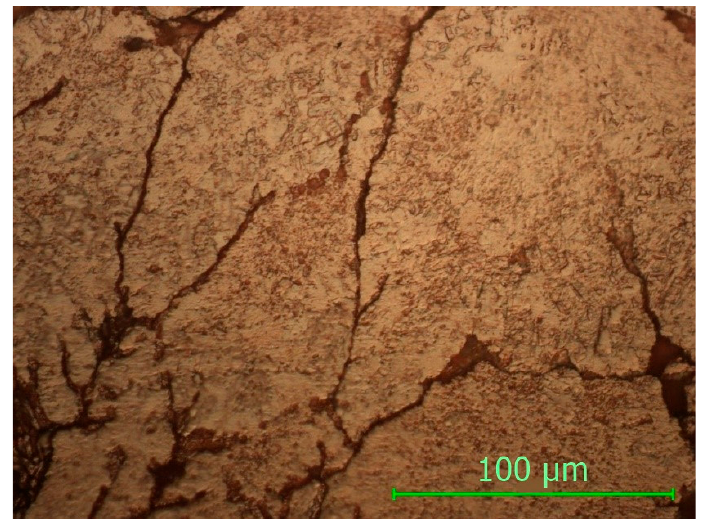
Figure 7. Non ‐ sintered sample, magnification 500×. Figure 7. Non-sintered sample, magnification 500 ×